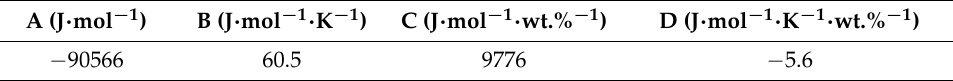
Table 2. Constants for Equation (1) in